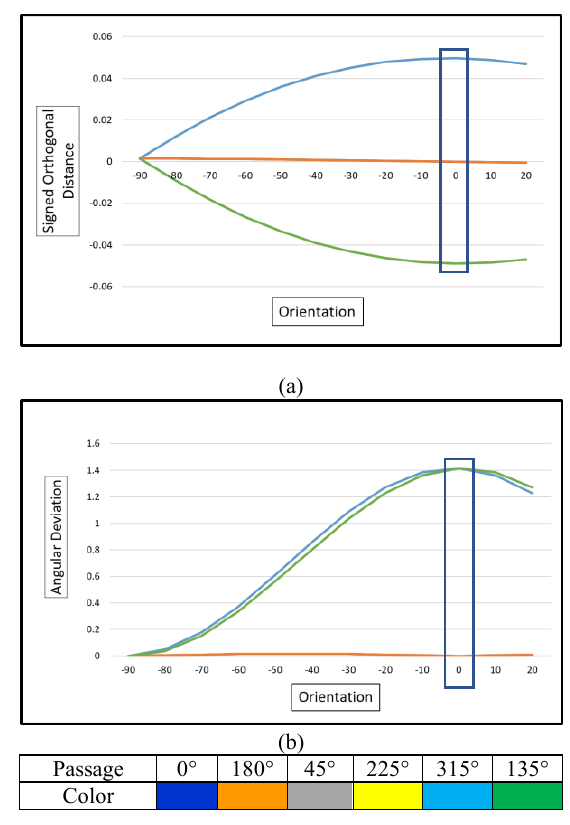
Figure 11 – Pitch boresight angle systematic error Type (II) criteria (a) Signed orthogonal distance (vertical axis in meter) and (b) Angular deviation (vertical axis in degree) of possible orientations (horizontal axis in